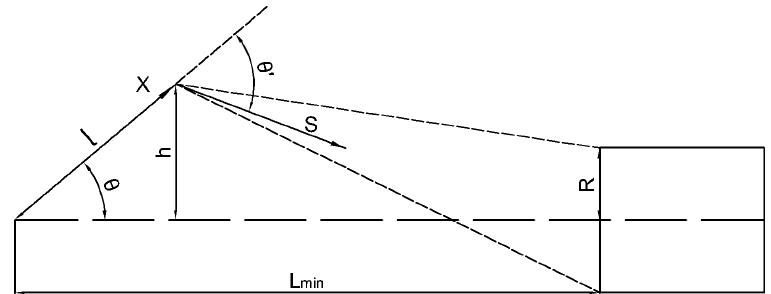
Figure 7 . Decay of long-lived meson X into